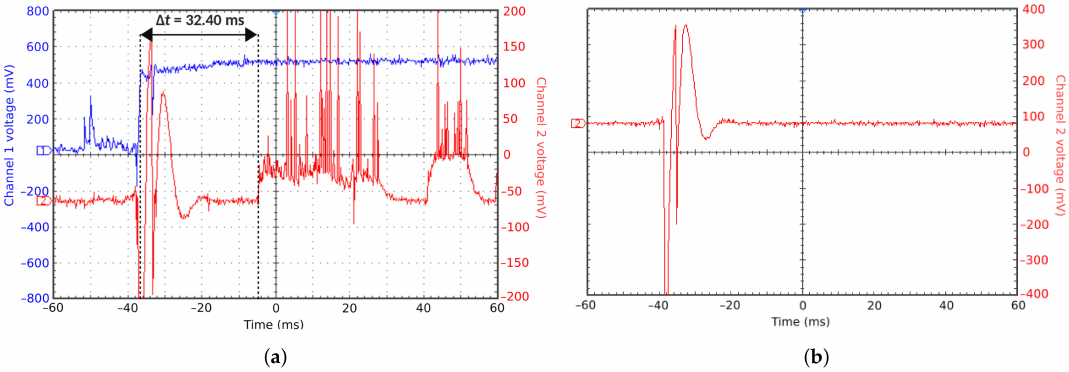
Figure 6. ( a ) An example of a record from the oscilloscope and its analysis. Blue curve (channel 1)—raw voltage signal; Red curve (channel 2)—raw current signal measured as voltage on resistor R3 (see Figure 4). Tops of the rising edges of voltage and current signals are marked by vertical dashed lines. The reading 32.40 ms corresponds to their time difference. The high-amplitude damped oscillation of current accompanying the rise of voltage are merely the artifact of voltage discontinuity at closing the switch and do not indicate any response of the sample. Blank measurement without the droplet shows the same feature in the current signal, see ( b ) (voltage was not recorded). Setup I was used at air temperature 24.0 ◦ C and relative humidity 60%. Images were exported from the oscilloscope and edited by Inkscape [14]. Vertical offsets of the curves are arbitrarily adjusted for viewing purposes.